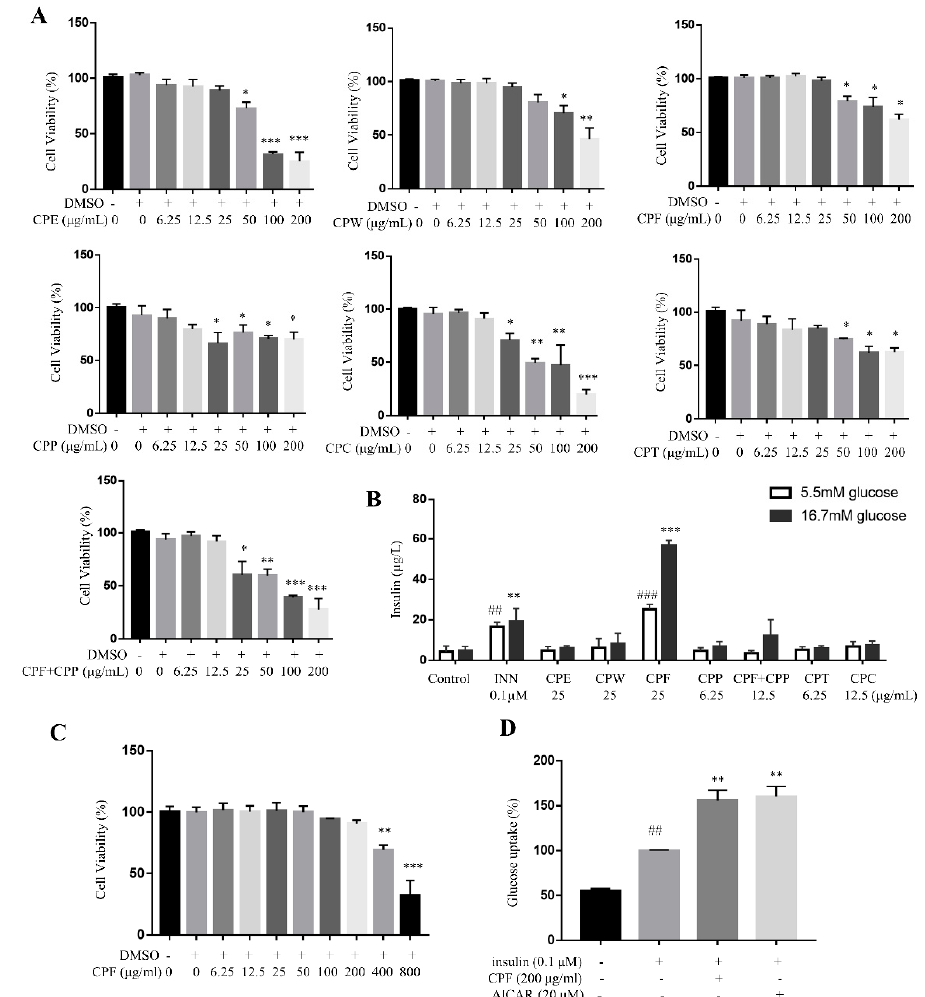
Figure 3. CPF (flavonoids fraction from C. paliurus leaves) enhanced glucose-stimulated insulin secretion in MIN6 cells and insulin-stimulated glucose uptake in C2C12 myotubes. ( A ) Cytotoxicity of different CP fractions on MIN6 cells, determined by MTT assay. n = 6, * p < 0.05, ** p < 0.01, *** p < 0.001, vs. DMSO. ( B ) CPF promoted glucose-stimulated insulin secretion in MIN6 cells. n = 6, ## p < 0.01, ### p < 0.001, vs. control cells in 5.5 mM glucose; ** p < 0.01, *** p < 0.001, vs. control cells in 16.7 mM glucose. ( C ) Cytotoxicity of CPF on C2C12 cells. ( D ) CPF promoted insulin-stimulated glucose uptake in C2C12 myotubes. n = 6, ## p < 0.01 insulin vs. control, ** p < 0.01, *** p < 0.001, CPF vs. insulin.